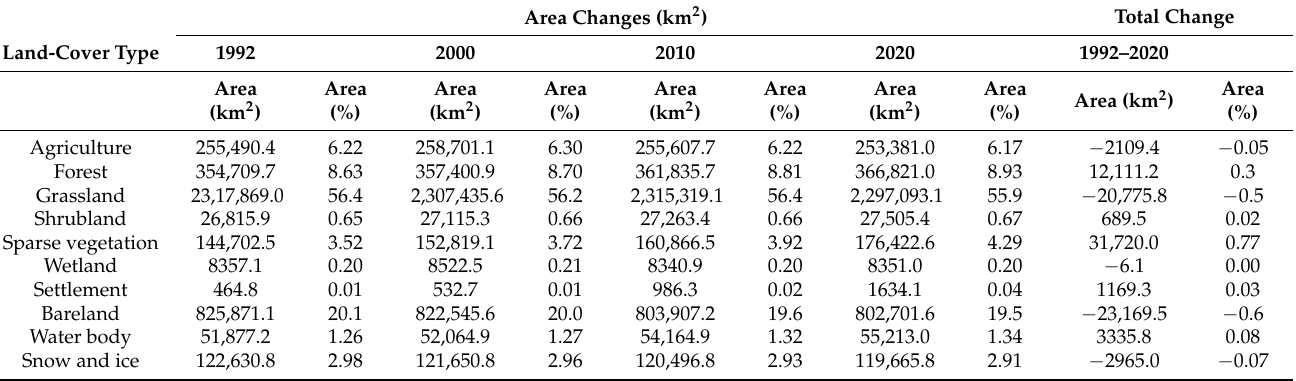
Table 2. Decadal Land-cover changes at the Third Pole from 1992 to 2020. Area Changes (km 2 ) Total